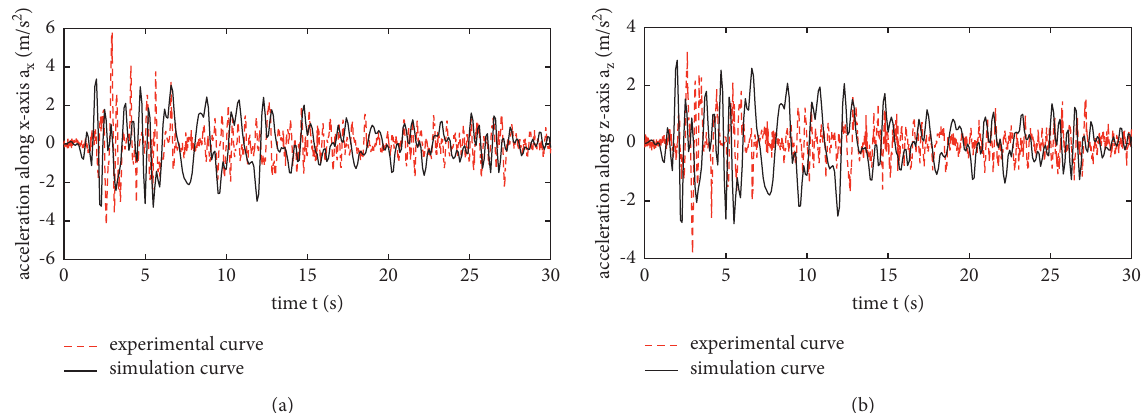
Figure 21: Comparison of lateral acceleration results of the top node. (a) Acceleration curve along the (x)-axis. (b) Acceleration curve along the (z)-axis.